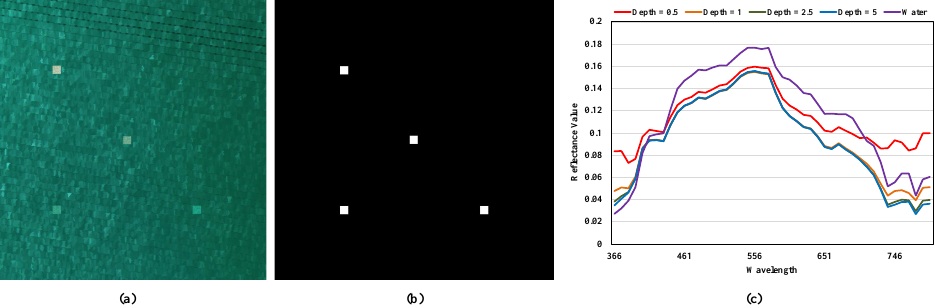
Figure 6. Synthetic data based on sea water for experiment. ( a ) Image scene of sea water; ( b ) distri- bution of desired targets; ( c ) spectra of desired targets and main backgrounds.